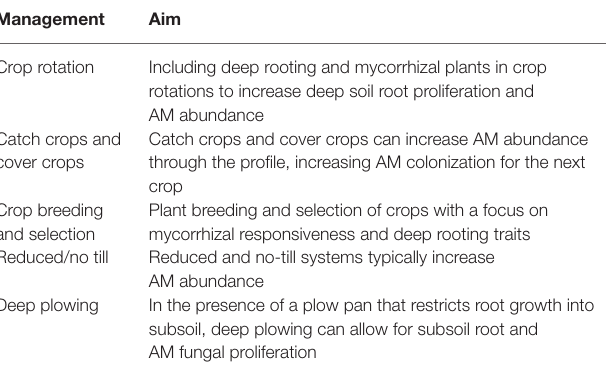
TABLE 1 | Suggested management approaches to foster subsoil AM